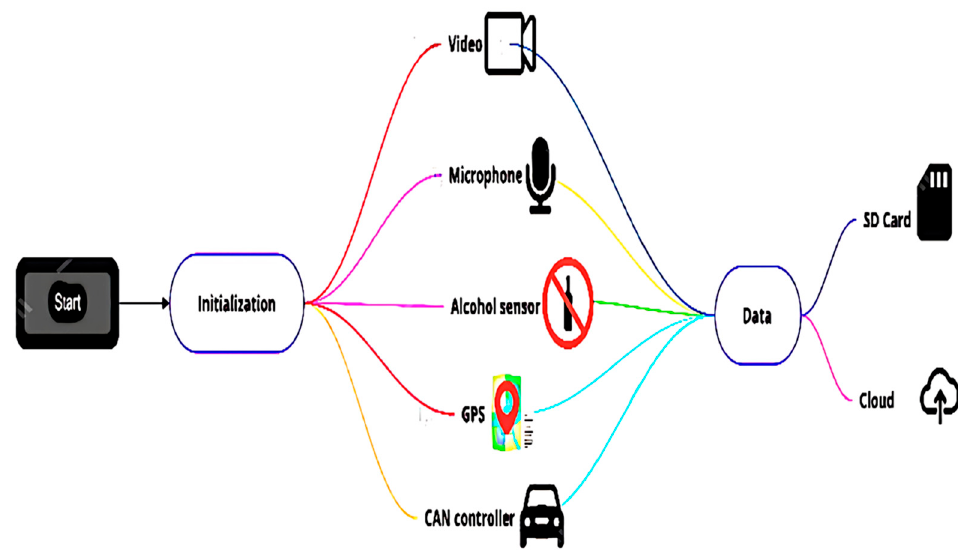
Figure 4. A schematic of the car ′ s black box system.